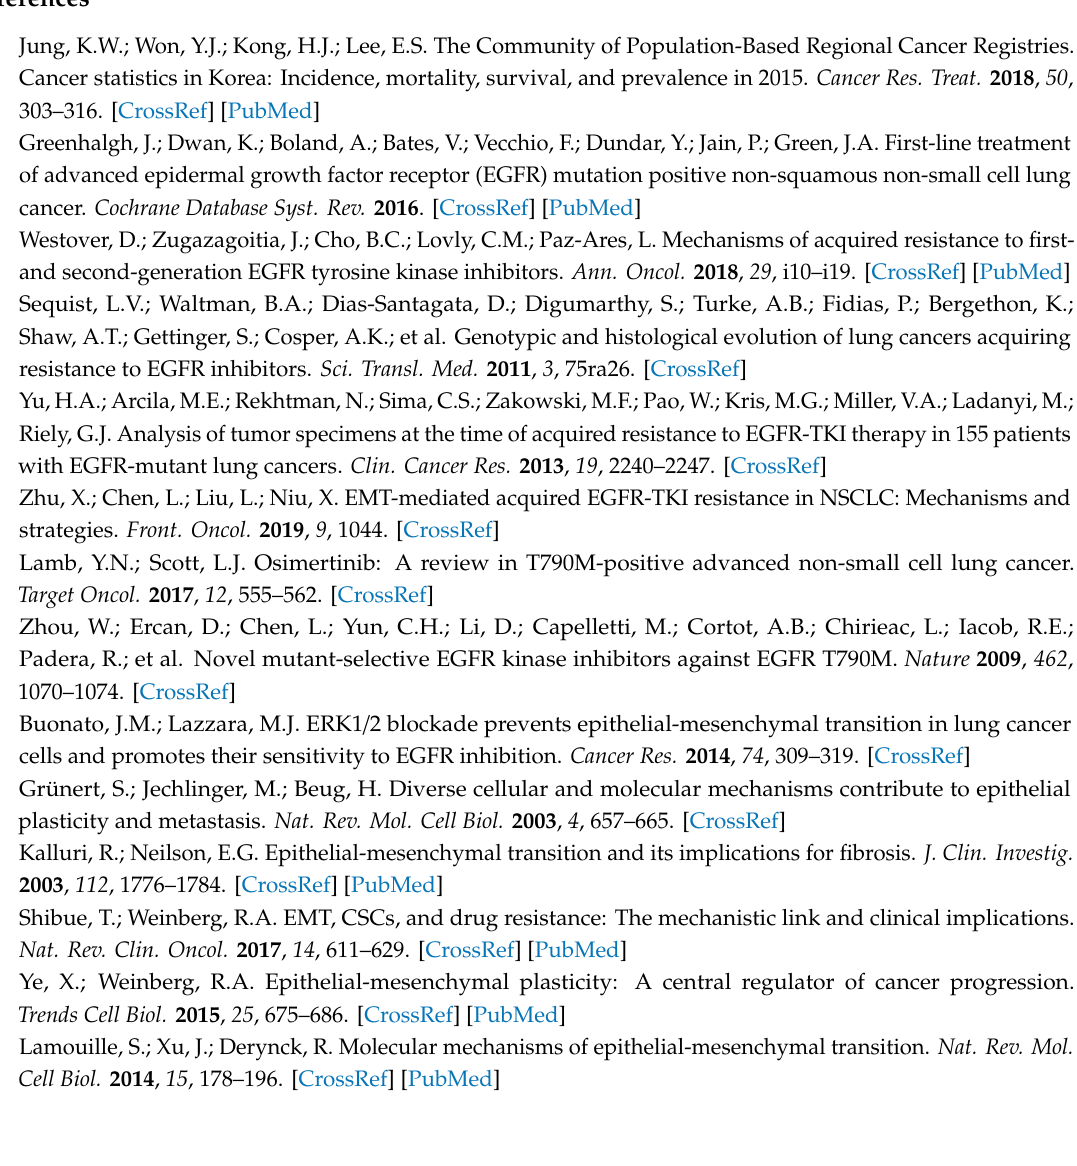
Figure S1: IC50 values of THZ1-tolerant cells., Figure S2: Changes of EMT-related molecules in THZ1-tolerant cells., Figure S3: The analysis of RNA-seq data from parental and 3rd-generation EGFR-TKIs-resistant cells., Figure S4: Comparisons between the basal levels of parental and both resistant cell